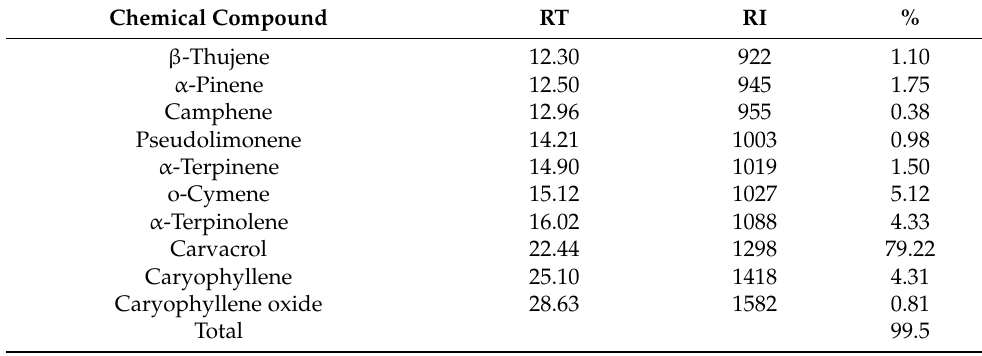
Figure 3. Chromatographic profile by GC-MS of Thymus capitatus essential oil leaves. Table 3. Chemical composition of Thymus capitatus essential oil leaves (percentage—%, retention time-RT, and retention